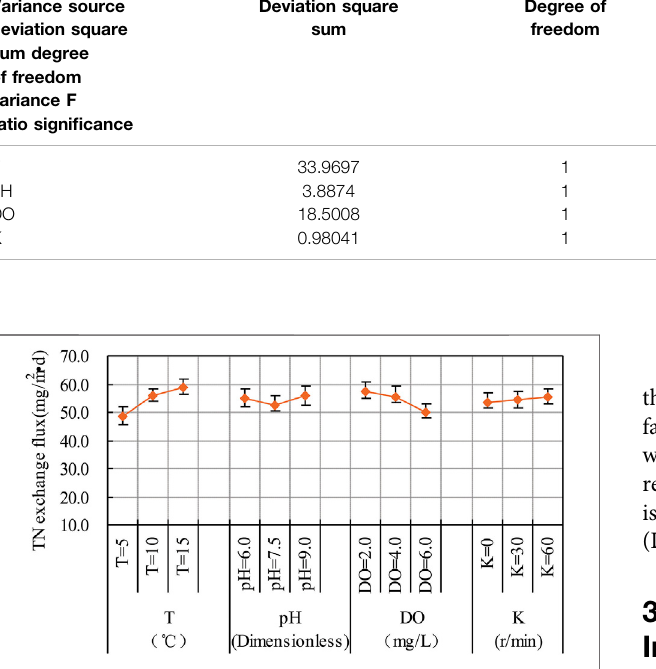
FIGURE 3 | Square deviation analysis of the total nitrogen released from the Dahekou sediments during the orthogonal